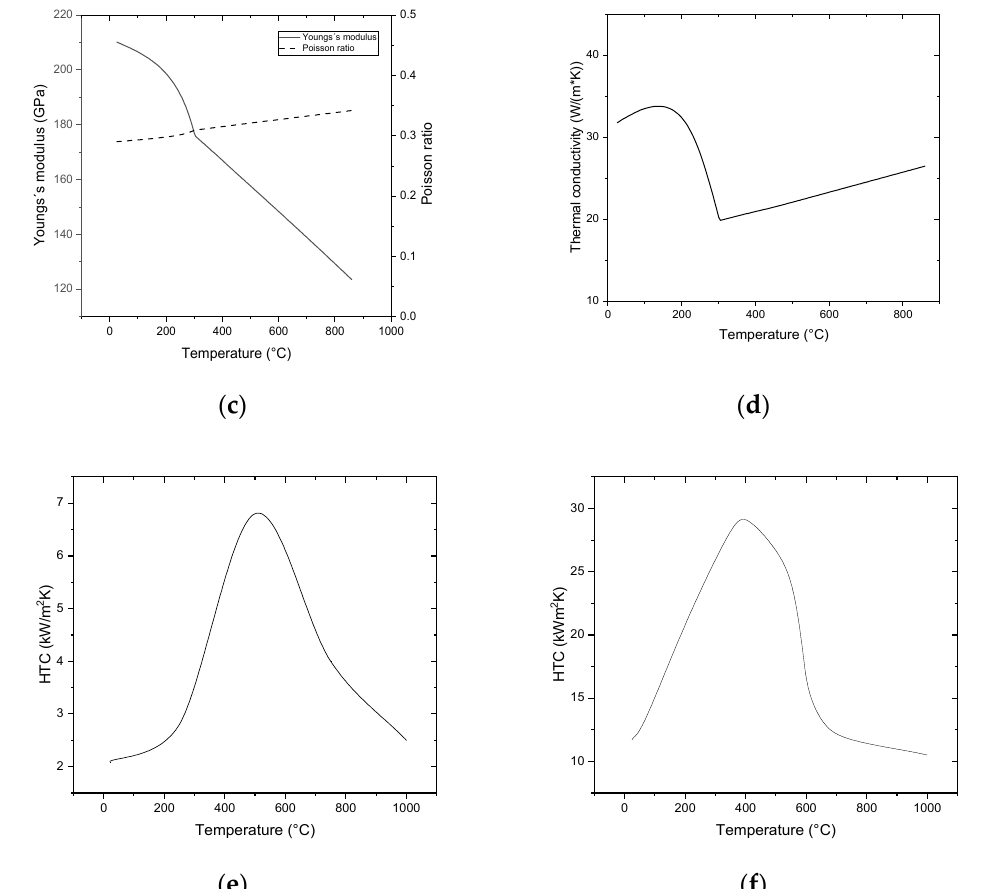
Figure 3. Thermophysical properties for AISI 4340 steel used in FEM simulation: ( a ) TTT diagram [37]; ( b ) thermal expansion [38]; ( c ) Young´s modulus and Poisson’s ratio [38]; ( d ) thermal conductivity [38]; ( e ) HTC (oil) adapted with permission from [39] 2022, Elsevier; and ( f ) HTC (water) [40].